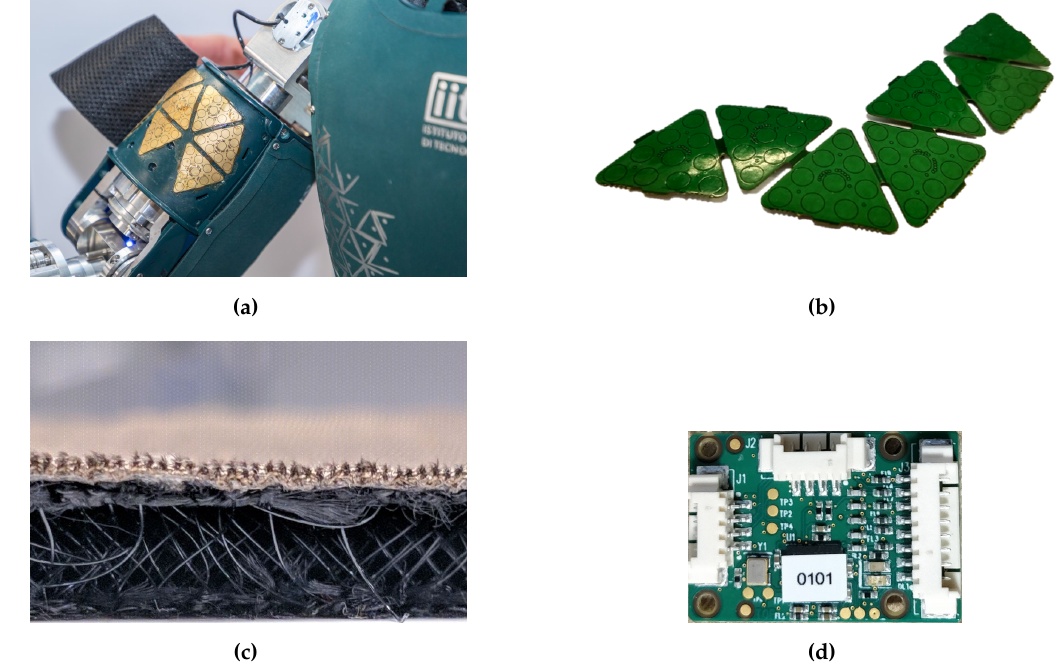
Figure 1. ( a ) Main components of the iCub skin. ( b ) Array of capacitive sensors. Each sensor implements 12 taxels and hosts the capacitive transduction electronics. ( c ) Deformable dielectric with conductive top layer. ( d ) Micro-controller tactile board (MTB).